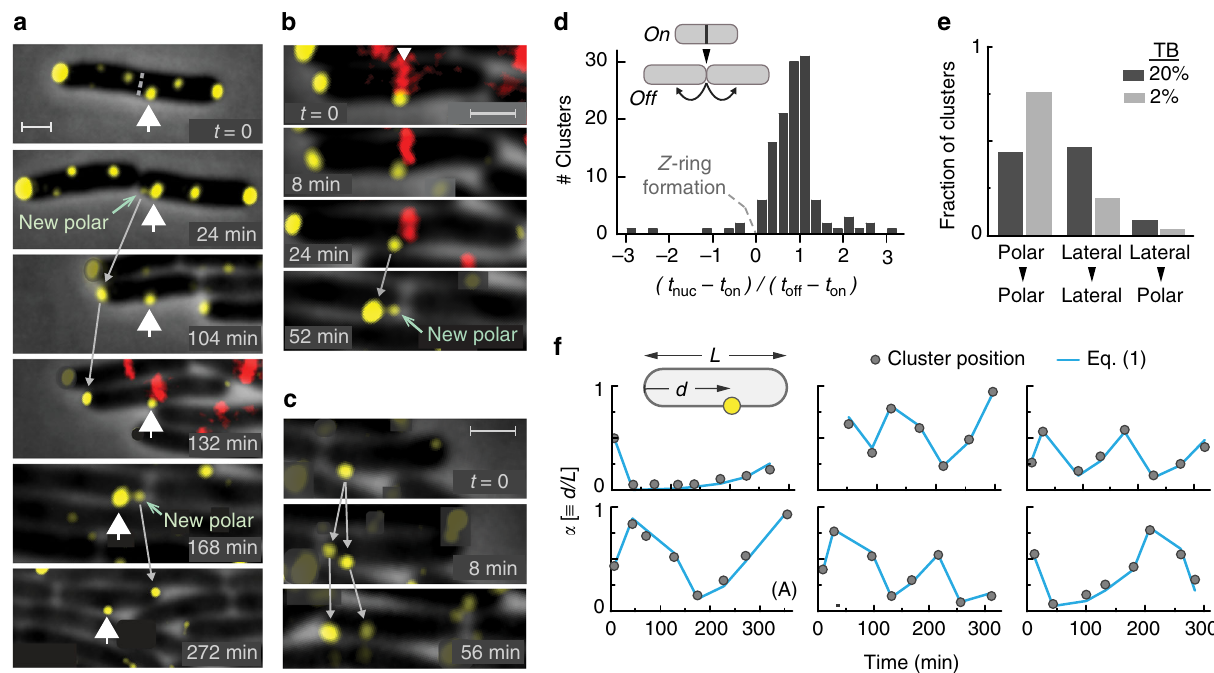
Fig. 2 Typical long-term positional dynamics of clusters in the cheA::mYFP (MK4) cells. a In this example, cells also expressed FtsZ-mCherry (induced by 0.005% arabinose); however, for clarity, the mCherry overlay was added only at the 132 min time point. The central cluster tracked here is labeled throughout the time series by a thick white arrowhead. The new clusters that appeared near the central cluster in the cell pole at 24 and 168 min time points are also labeled. For clarity, few of the high intensity clusters in cells other than those in focus were masked. Fluorescence images were recorded every 4 min, and only sample images are shown. b Similar to a with a focus on a single division event. c Example of a cluster near the cell pole that apparently split into two with one cluster remaining at the pole and the other drifting away. Scale bars corresponds to 1 µ m. d Histogram of polar-cluster nucleation times ( t nuc ) measured relative to the period between the assembly ( t on ) and disassembly ( t off ) of the Z -ring during the corresponding cell division (127 clusters). e Using cells without FtsZ-mCherry, clusters within a certain colony at a certain time point were identi fi ed and grouped according to their nucleation and fi nal positions, polar or lateral. The data are shown for cells grown in minimal medium containing 20% (dark gray) or 2% (light gray) TB (301 and 133 clusters, respectively). f The relative position of the clusters ( α ) was de fi ned as the distance between the cluster and a certain cell pole normalized by the length of the cell and is plotted as a function of time (gray circles). Each plot represents the trajectory of a single cluster whose position was quantitatively evaluated once every cell cycle, soon after cell division. The estimated uncertainty in the measured cluster relative position is approximately the size of the symbols. The blue lines were plotted by iterating equation (1). In total, 22 clusters from nine independent experiments were followed, each for several generations (see also Supplementary Fig.